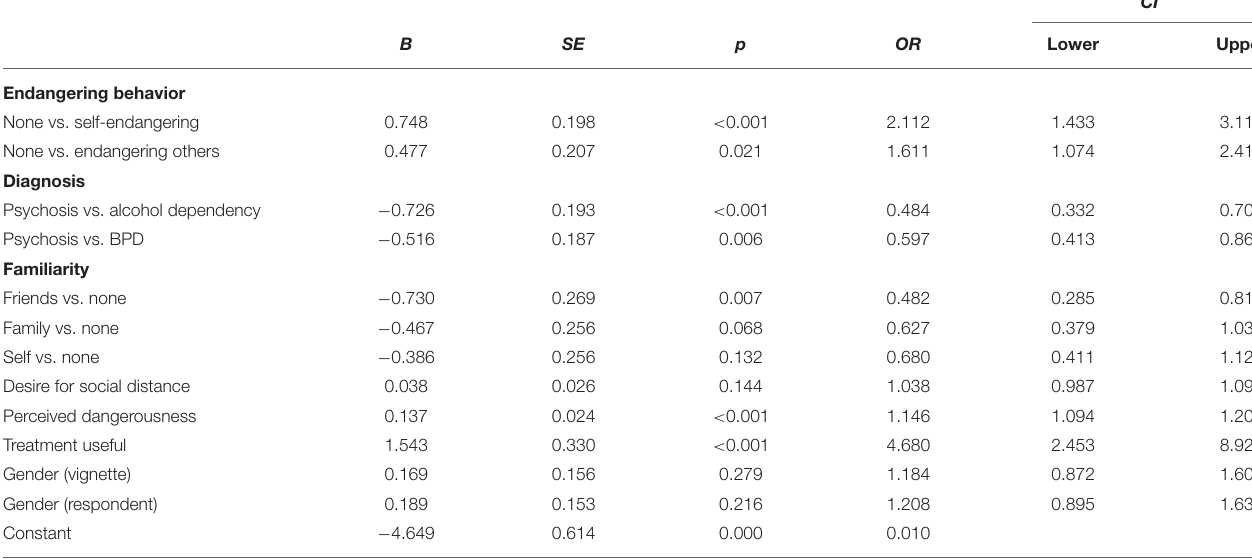
TABLE 2 | Logistic regression model for approval of any type of